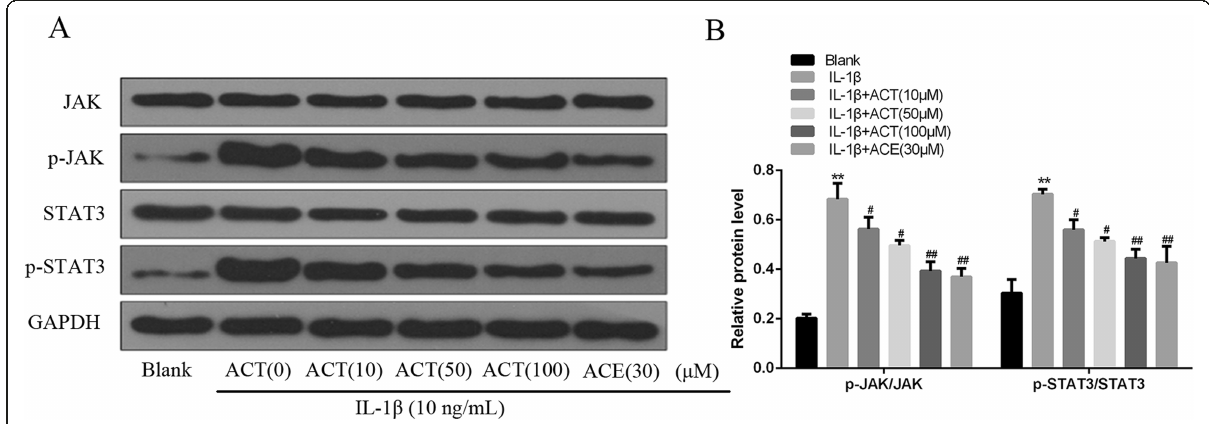
Fig. 4 ACT inhibits JAK/STAT signaling in primary chondrocytes. Rat primary chondrocytes were untreated or treated with 10 ng/mL IL-1 β together with different concentration of ACT ACE (positive control, 30 μ M) for 24 h. a , b JAK, p-JAK, STAT3 and p-STAT3 were analyzed. ** p < 0.01 and * p < 0.05 compared with blank group. # p < 0.05 compared with IL-1 β group. The experiment was repeated three times and the representative results were shown in ( a